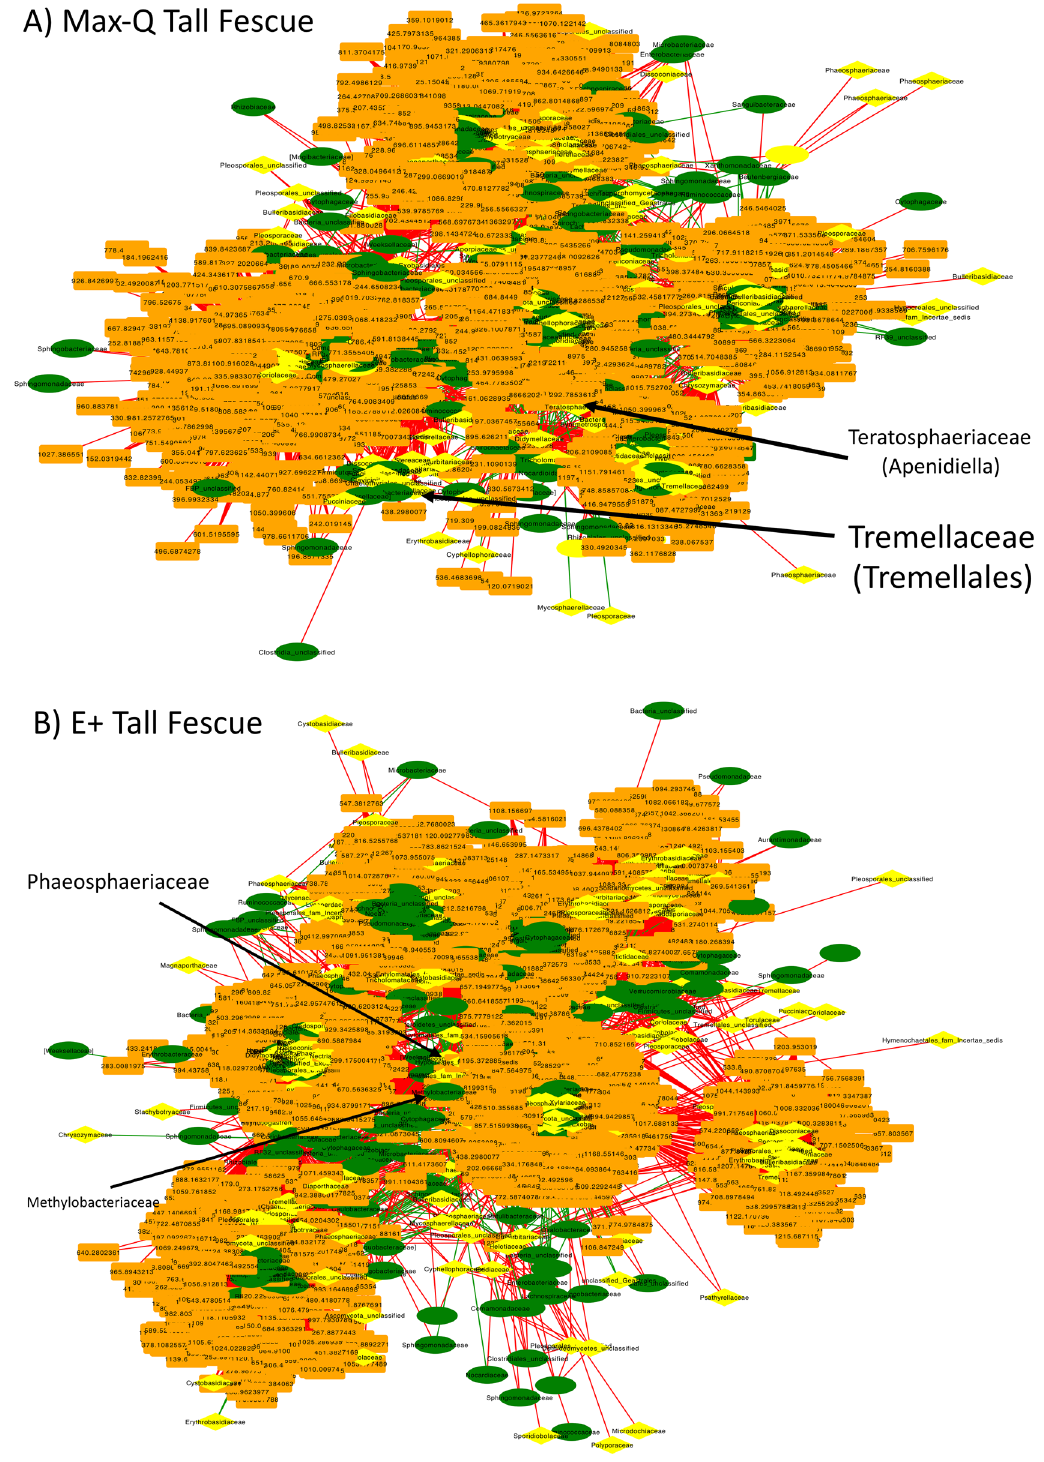
Figure 6. Global fescue plant integrative interactomics networks of relationships between bacterial (green, oval) and fungal (yellow, diamond) OTUs and metabolites (orange, rectangle) in the tall fescue plant within non-toxic ( A ; Max-Q; n = 6) or toxic ( B ; E+; n = 6) endophyte-infected plants. Green and red edges indicate positive and negative correlations, respectively. Select nodes of interest are highlighted by arrows and